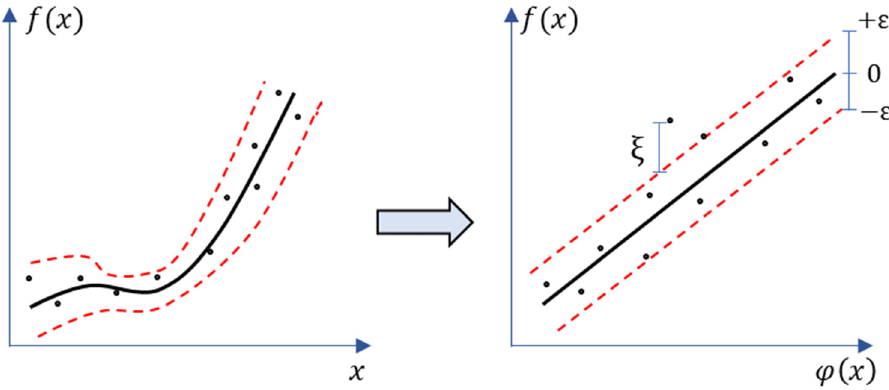
Figure 2. Mapping a non-linear support vector regression into feature space and its ε -insensitive